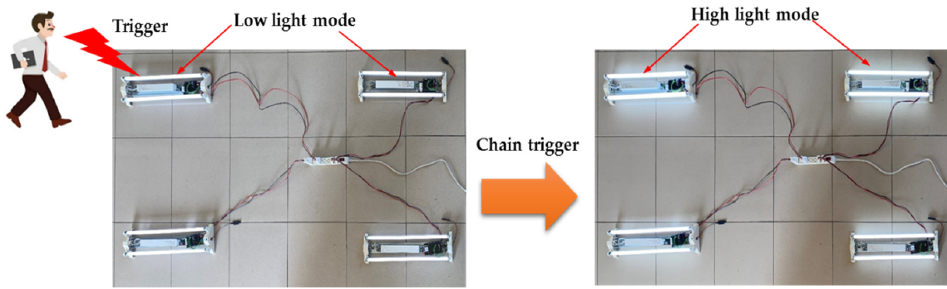
Figure 8. Actual test of the proposed system.